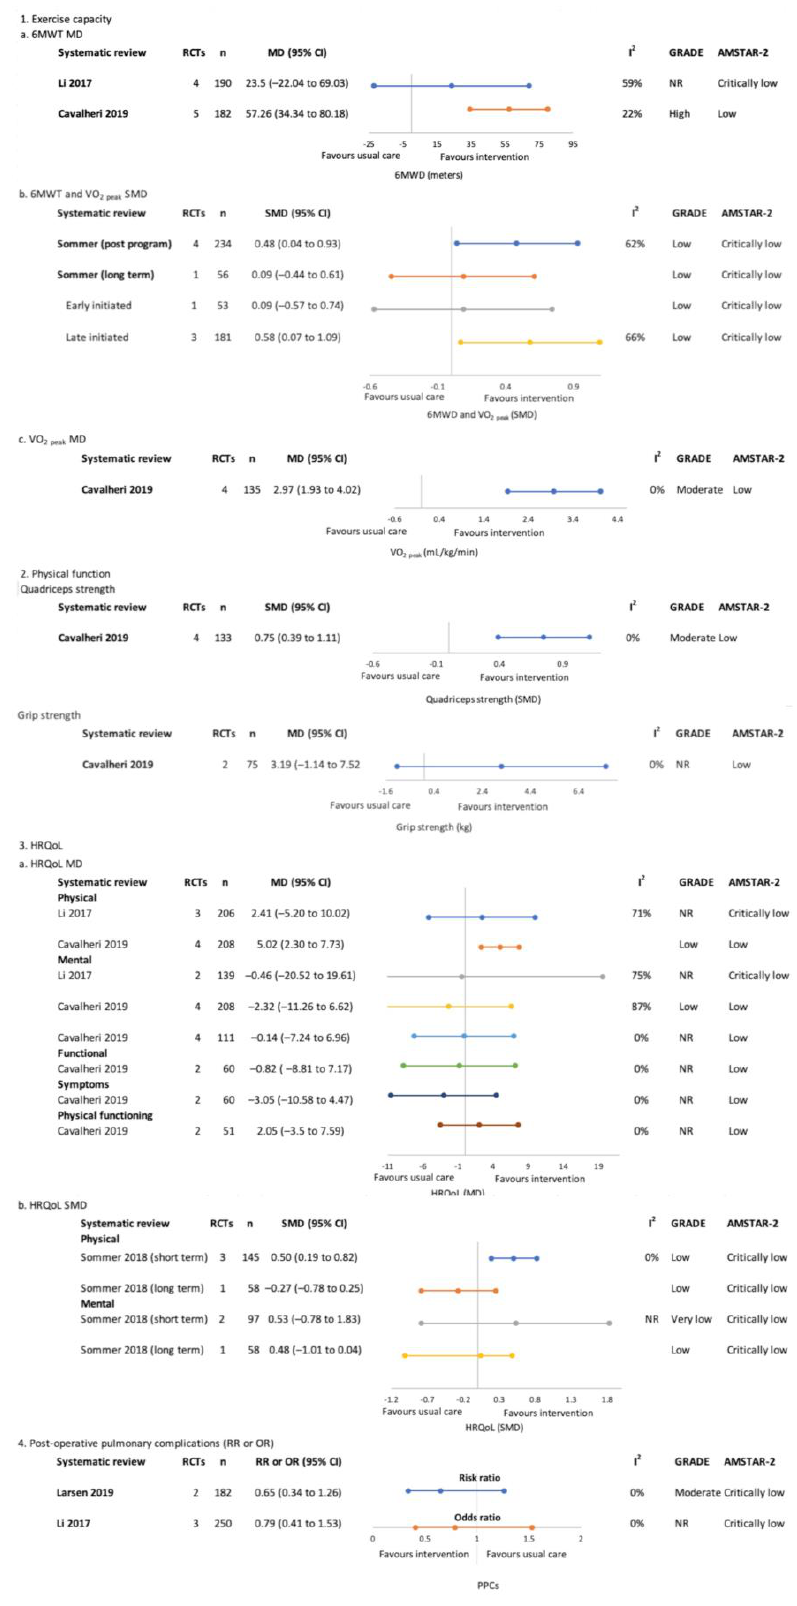
Figure 4. Post-treatment only (surgical)–meta-analysis findings for overview primary outcomes (1. Exercise capacity, 2. HRQoL and 3. Physical function and 4. Post-operative pulmonary complica- tions)